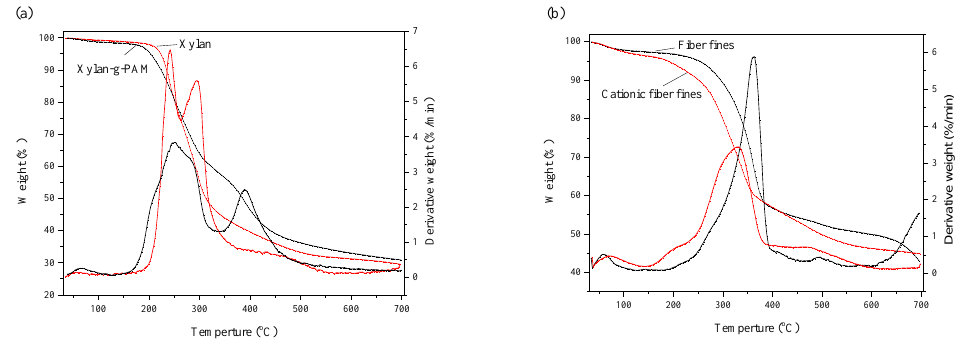
Figure 3. The TGA/DTA curves of xylan and xylan-g-PAM ( a ); fiber fines and cationic fiber fines ( b ).